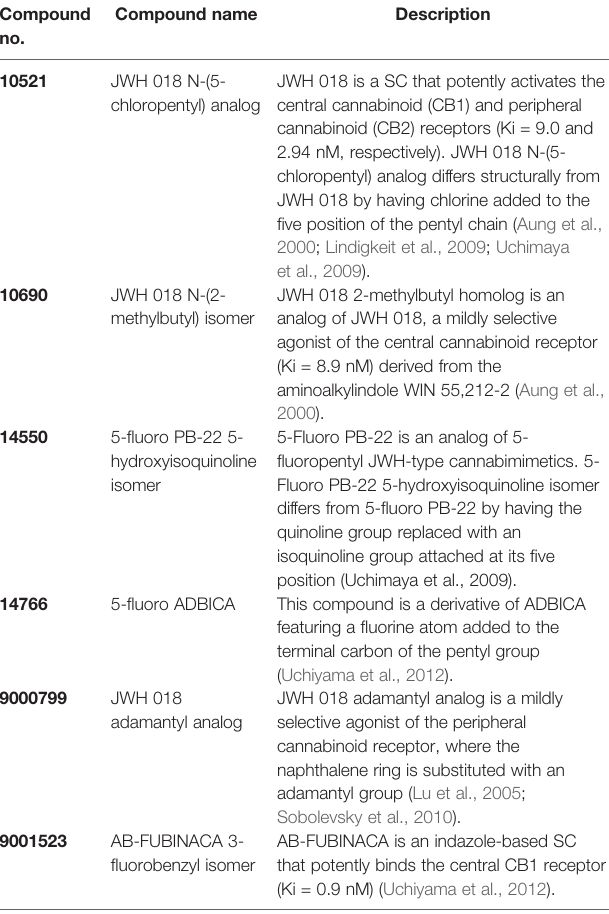
TABLE 1 | SC compounds identi fi ed to have anti-seizure properties in scn1lab mutant zebra fi sh larvae. Compound